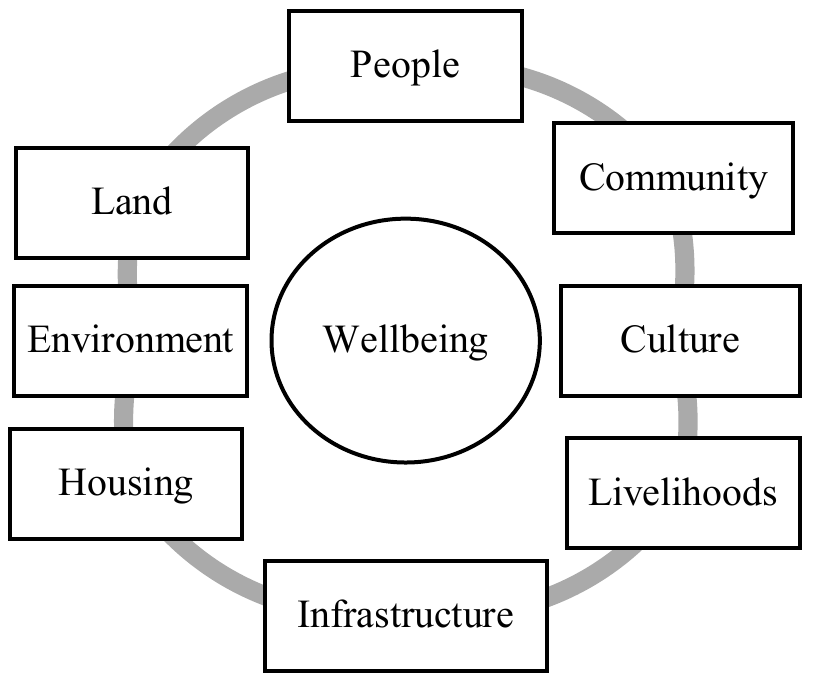
Figure 7. Schematic of the social analysis framework. Table 4 summarizes the impact of 3DP on the different social aspects. The following sections discuss the social impacts of the 3DP technology with the aid of the social aspects presented in Table